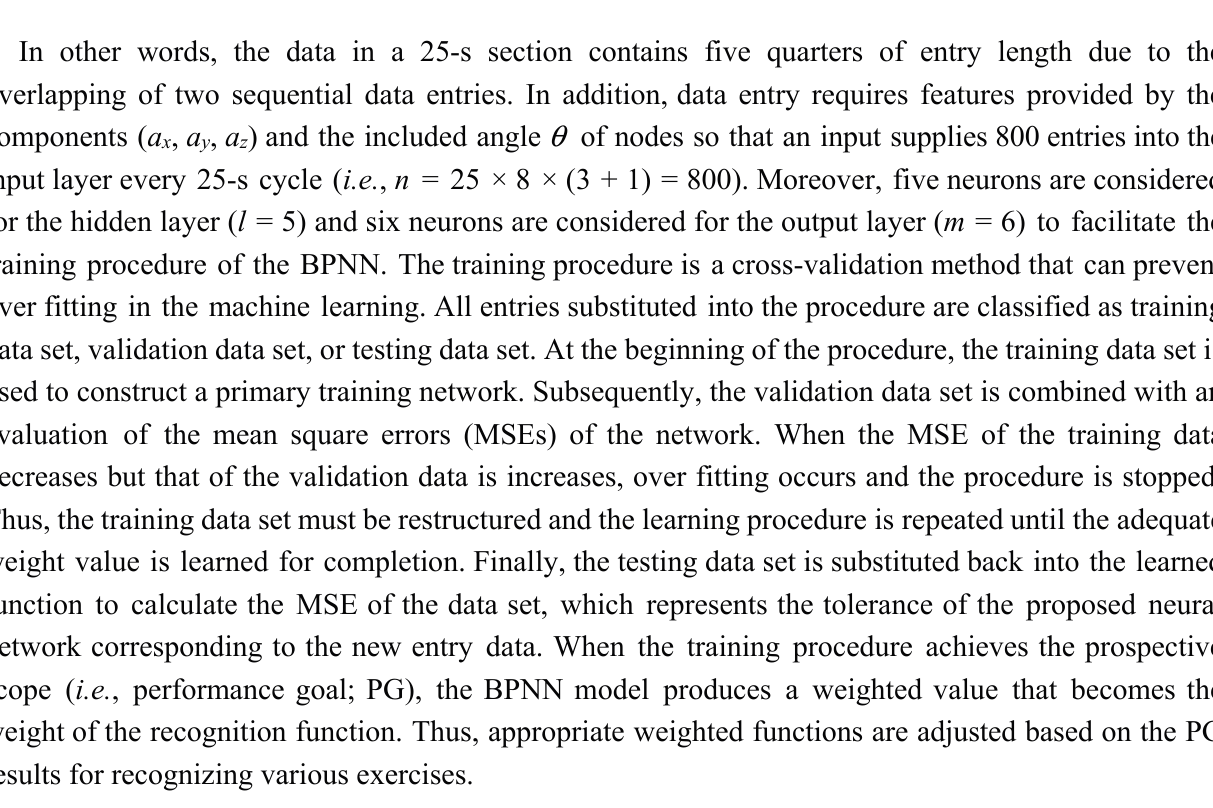
Table 1. Test records of the exercises made by the sample group and the control